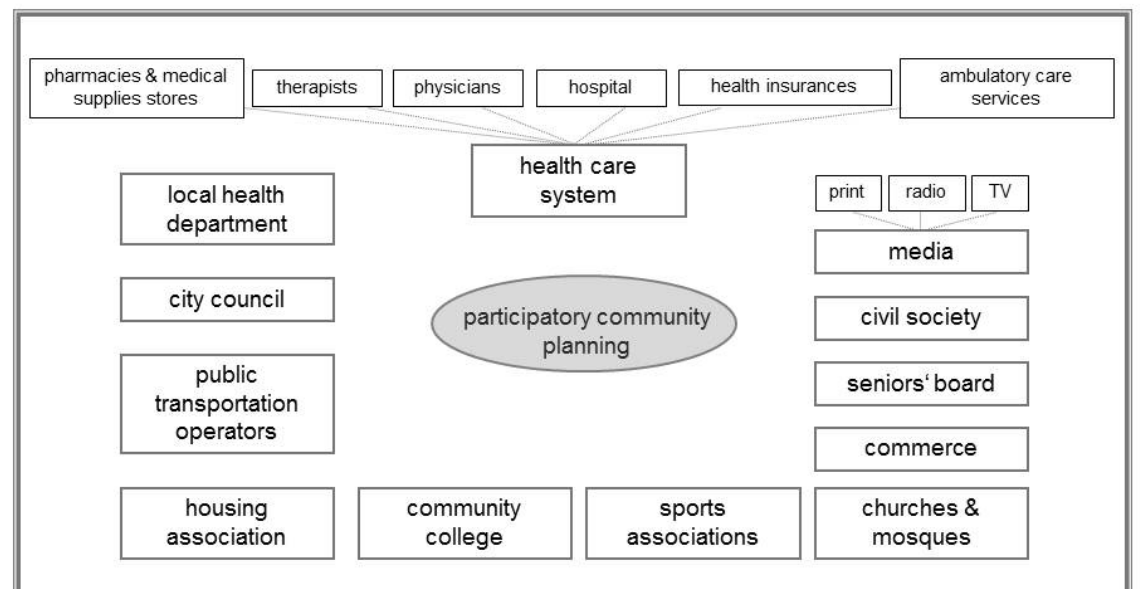
Figure 1. Local stakeholders involved in the participatory community